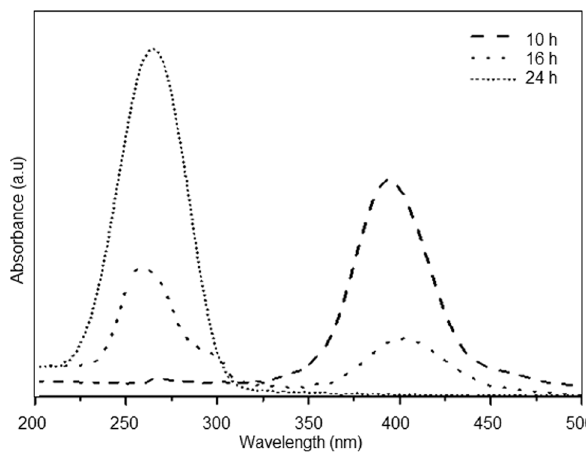
Figure 5: UV - Vis spectra of NiNPs at a reaction time of 10, 16, and 24 h.